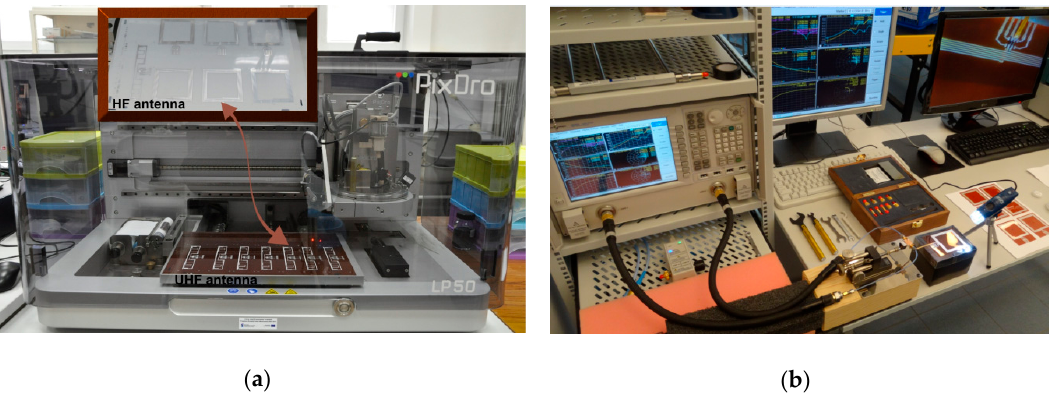
Table 2. Impedance of ink-jet printed flexible antenna dedicated to the UHF band.